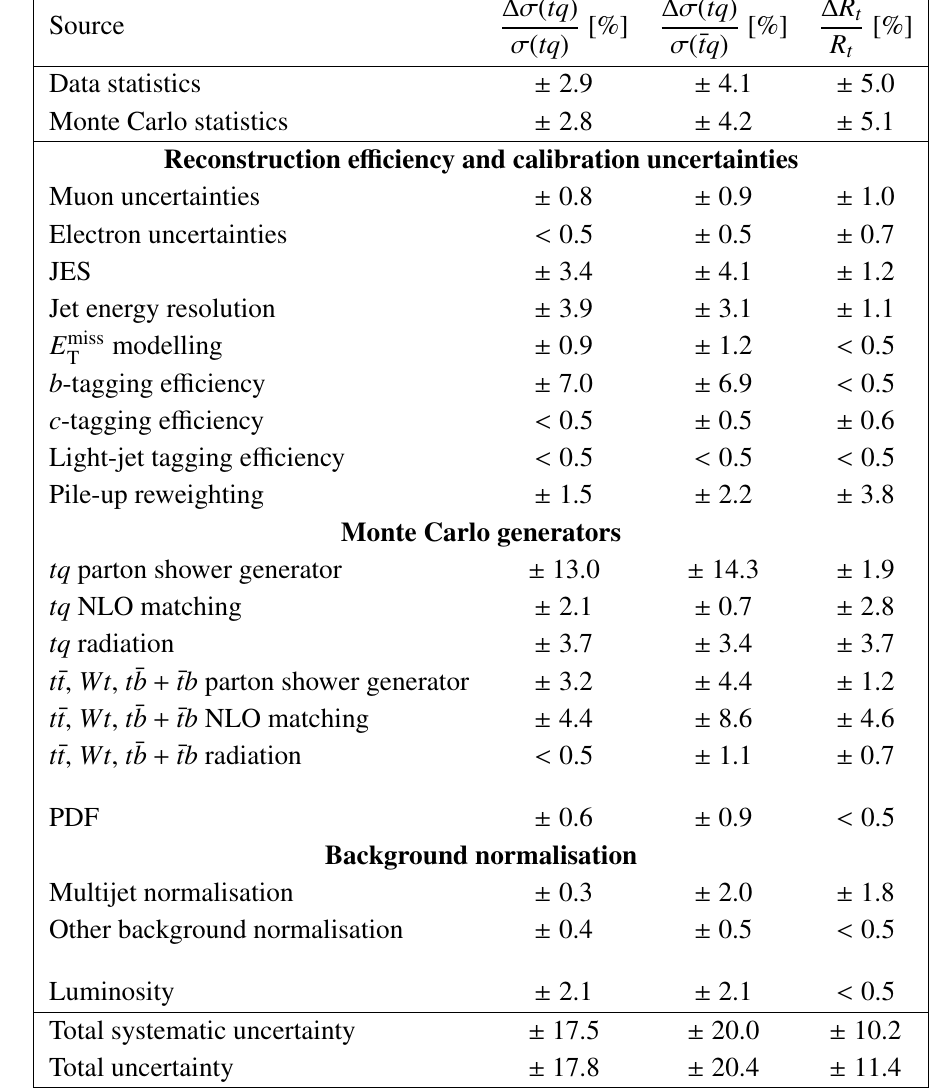
Table 4 . List of systematic uncertainties contributing to the total uncertainty in the measured values of (cid:27) ( tq ), (cid:27) (¯ tq ), and R t = (cid:27) ( tq ) =(cid:27) (¯ tq ). The estimation of the systematic uncertainties has a statistical uncertainty of 0.3 %. Uncertainties contributing less than 0.5 % are marked with “ < 0 :